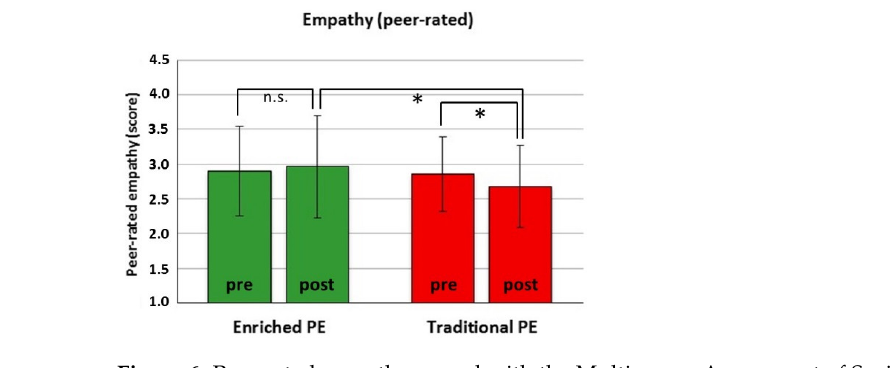
Figure 5. Peer-rated cooperation scored with the Multisource Assessment of Social Competence Scale before (pre) and after (post) the actual enriched PE intervention or the traditional PE. * p < 0.016 (adjusted for three comparisons); n.s.: non-significant.